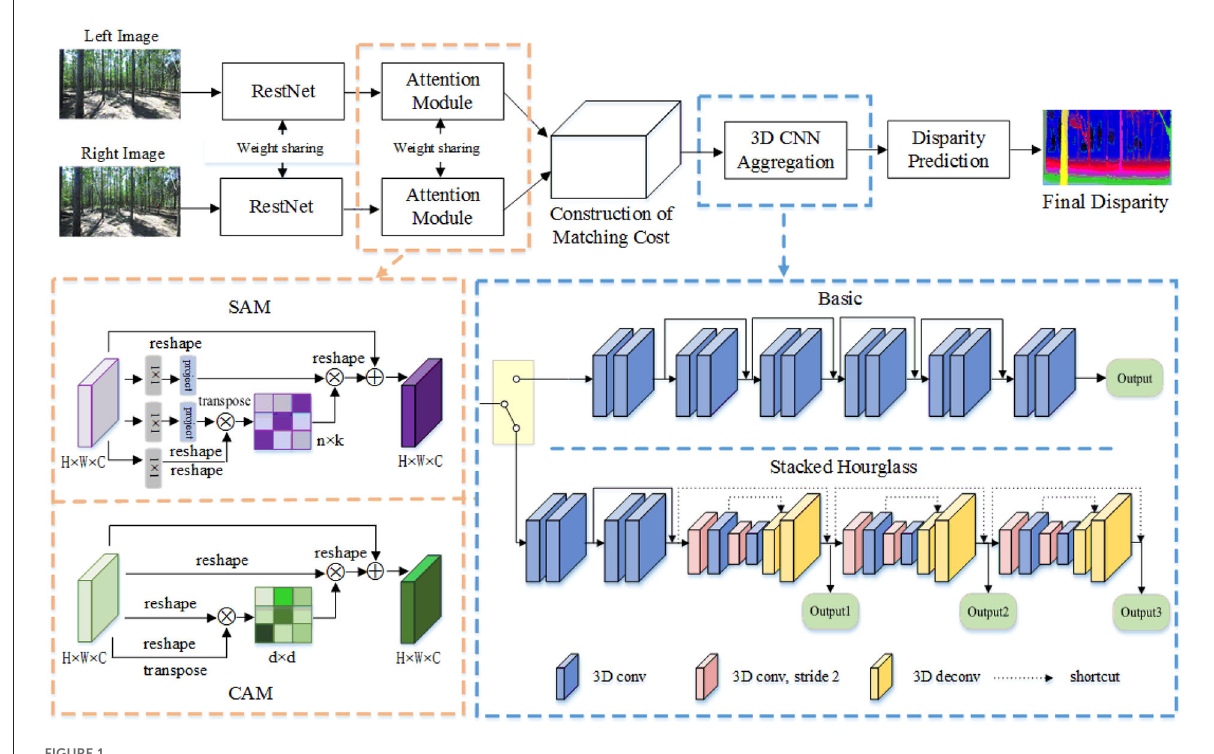
FIGURE1 Architecture overview of proposed